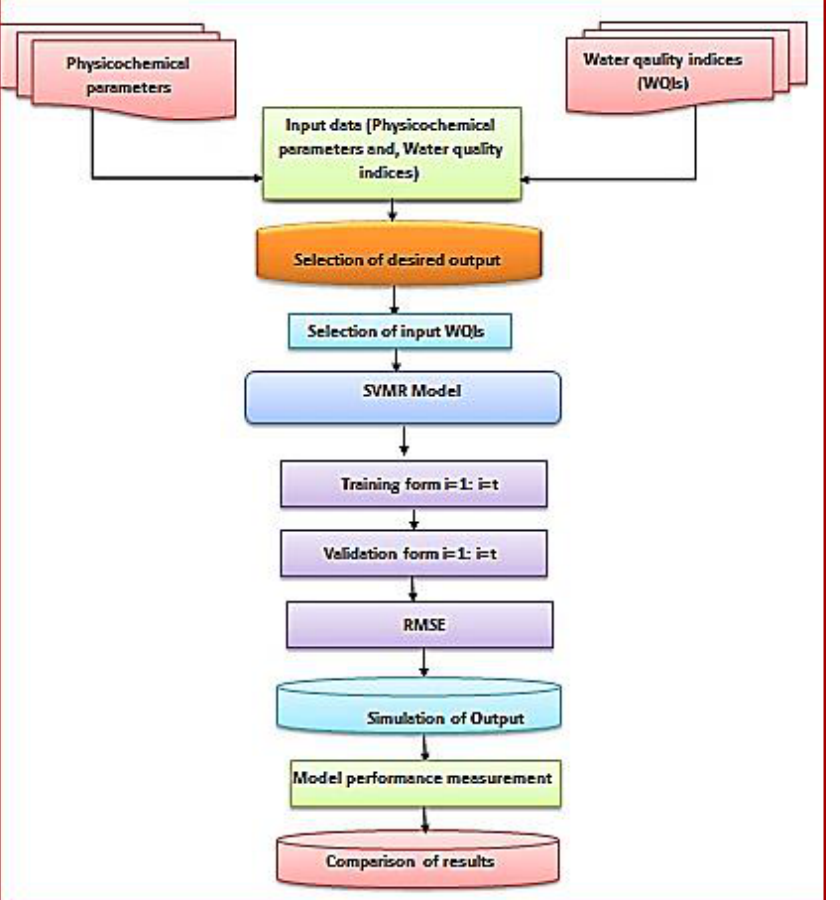
Figure 4. Diagram illustrating the SVMR methodology used in this study to forecast IWQI, Na%, SAR, SSP, KI, PI, PS, and RSC on the basis of the chosen chemical parameters.